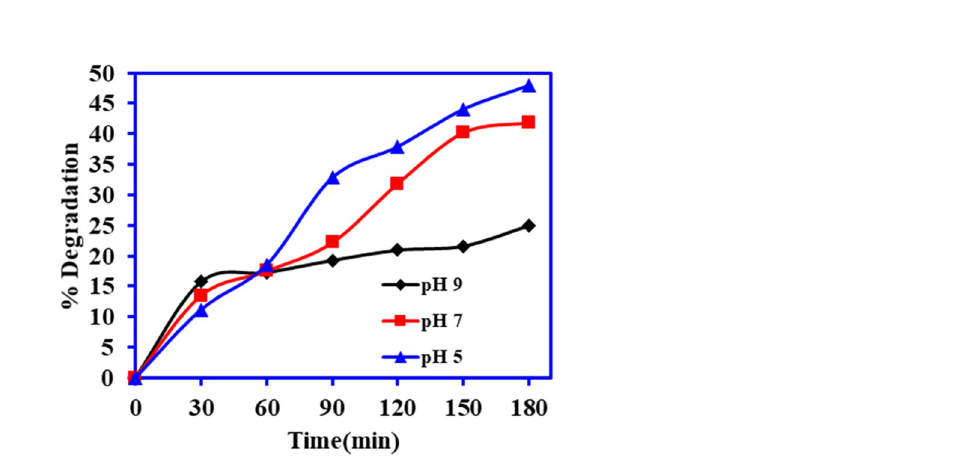
Figure 8. Effect of catalyst mass on the photocatalytic activity of BiOCl–GO composite on DCF (conc. 25 mg L −1 , pH 6, vol.—100 mL).